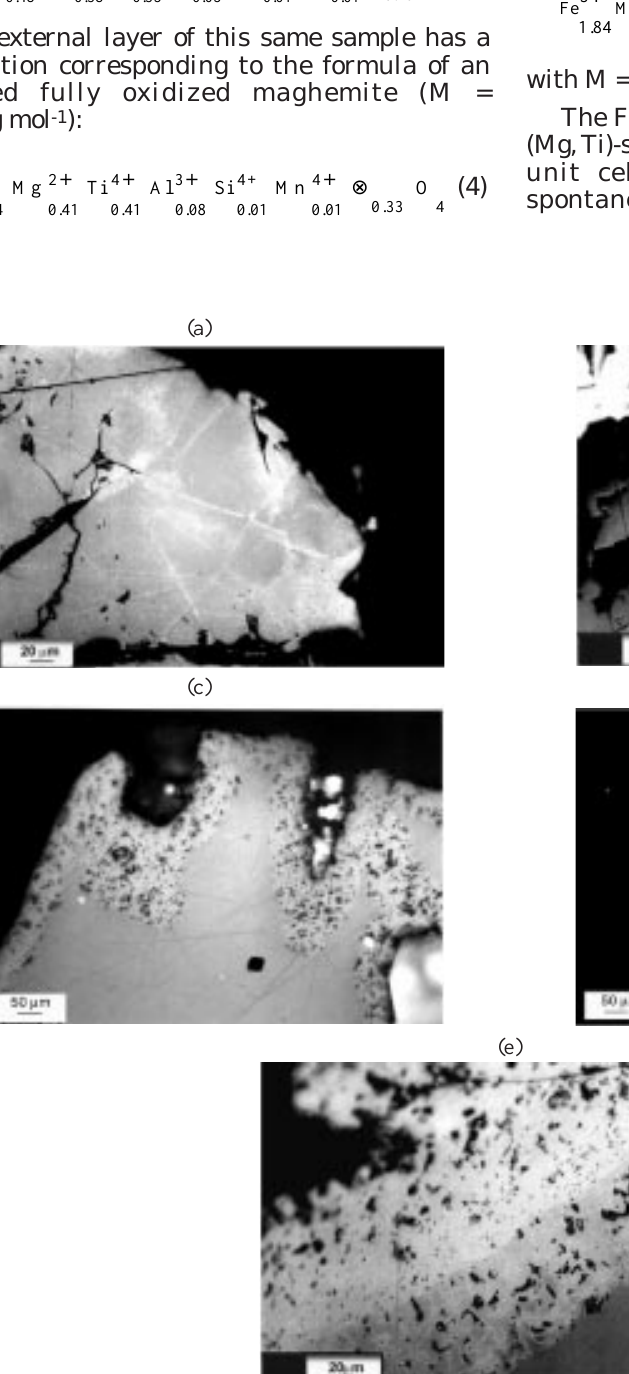
Figure 3. Optical micrographs, taken under a petrographical microscope with polarized light, of polished sections of crystals separated from samples collected from a tuffite mantle, at depths of (a) 4 m, with exsolution of hematite; (b) 6 m, with presence of ilmenite; (c) 10 m, with two alteration zones, an inner core and an oxidized external layer; (d) 12 m, presenting exsolution of hematite, along with inclusions of ilmenite and (e) 14 m, showing three alteration zones labeled A, B and